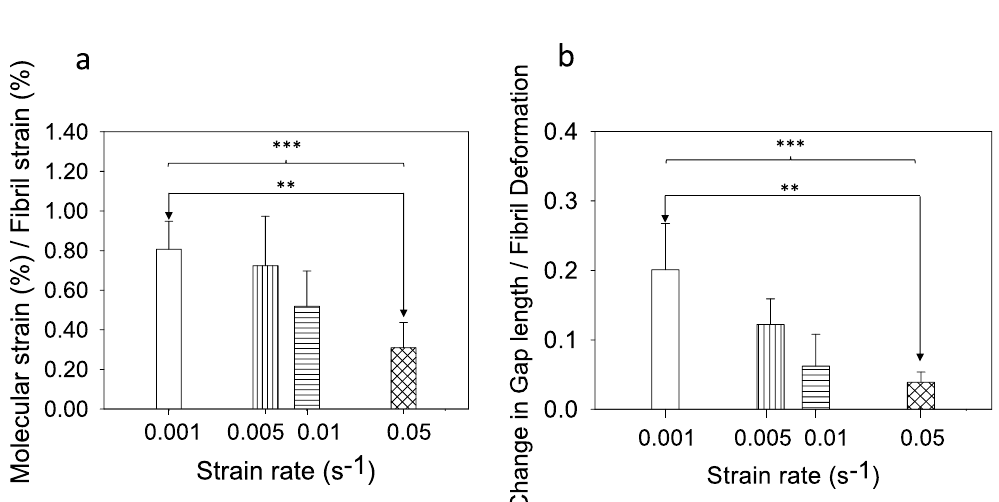
Figure 3. ( a ) Mean molecular strain % to fibril strain % ratio and ( b ) change in gap length to fibril deformation. Error bars are standard deviations (n = 5 for each bar). ( * p < 0.05, ** p < 0.01, *** p <